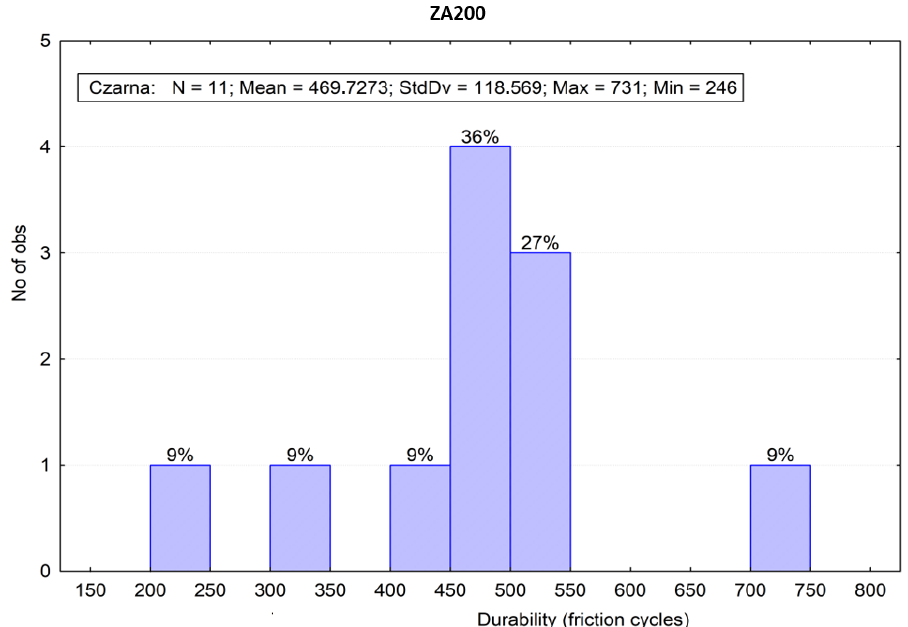
Figure 8. Frequencies of the sliding friction test results of the “black” (ZA200) coating.